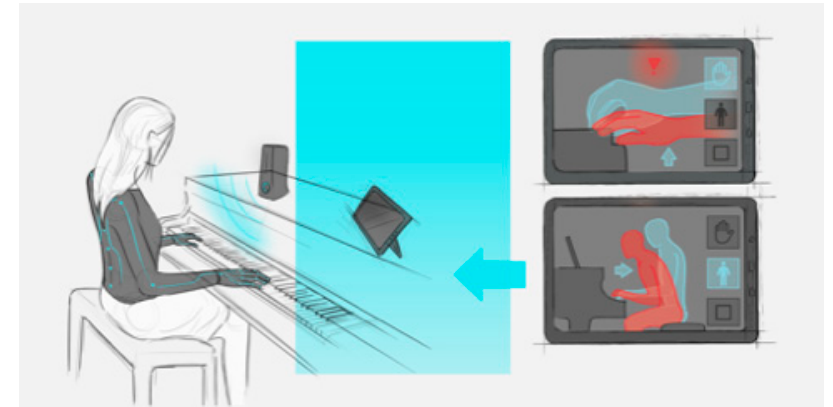
Figure 2. Body movement